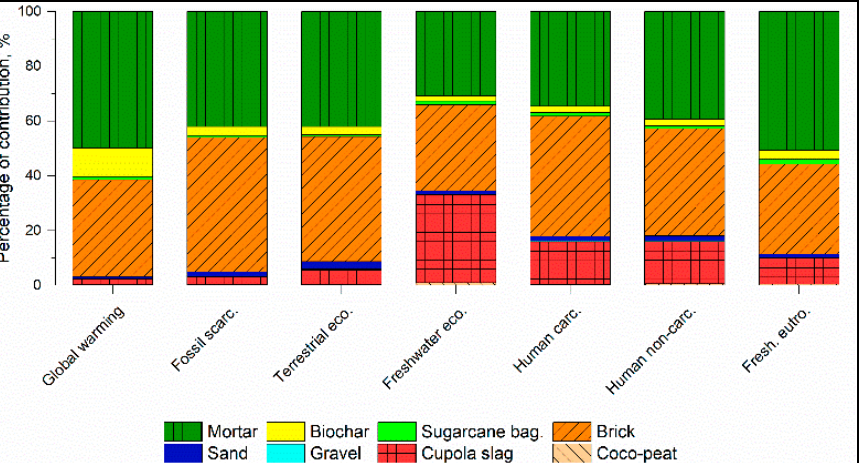
Figure 2. Comparative impact assessment of utilized media materials from their respective life cycles on selected categories.